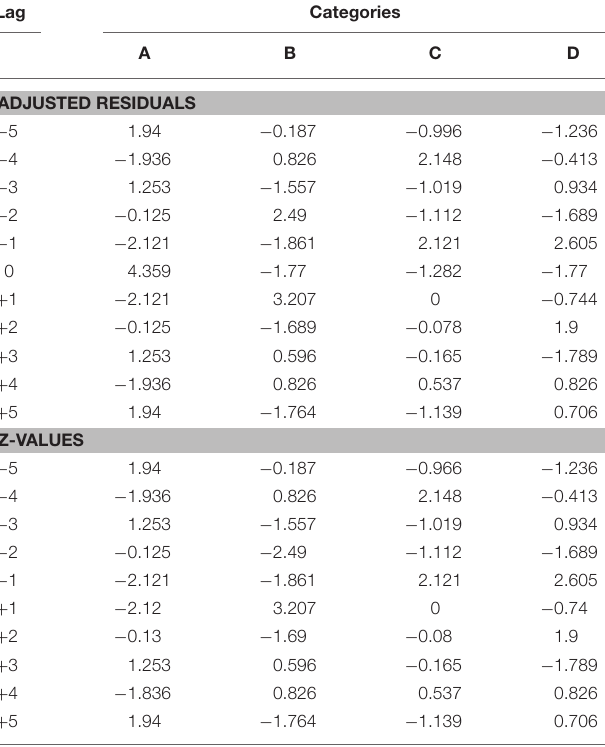
The analysis was performed in HOISAN.